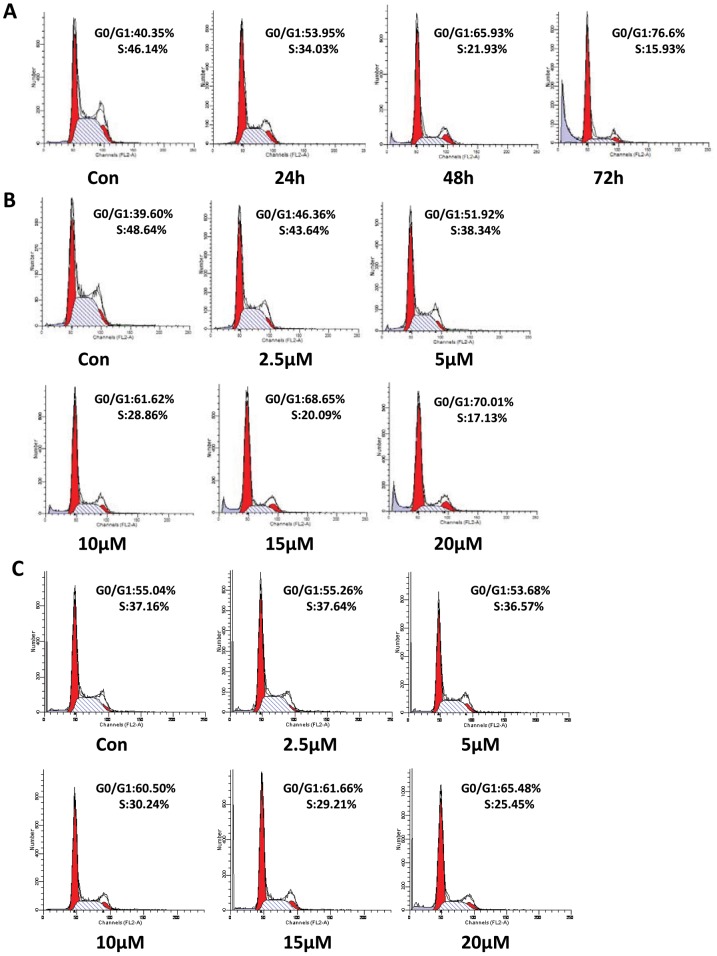
R2HBJJ induced G0/G1 Phase arrest on NSCLC cells.The cells were synchronized with 1% FBS for 24 h. After that, the cells were released into complete medium (10% FBS) containing 20 µM R2HBJJ for 24, 48, 72 h (A, H1299 cells) or various concentrations of R2HBJJ (2.5–20 µM) for 48 h (B, H1299 cells; C, H157 cells). Cells treated with solvent (DMSO) were used as a control. Cell cycle distribution was determined by using flow cytometric assay. The histograms displayed here were representative of three experiments.